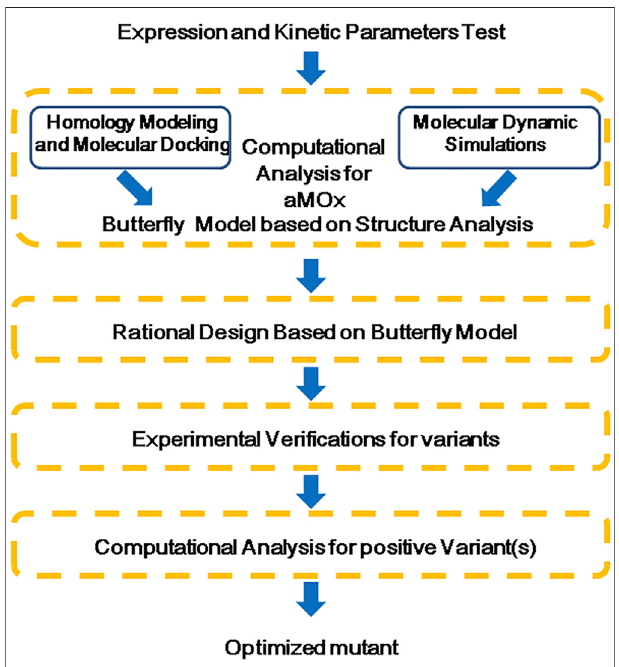
FIGURE 3 | Flow chart of a rational design for aMOx.